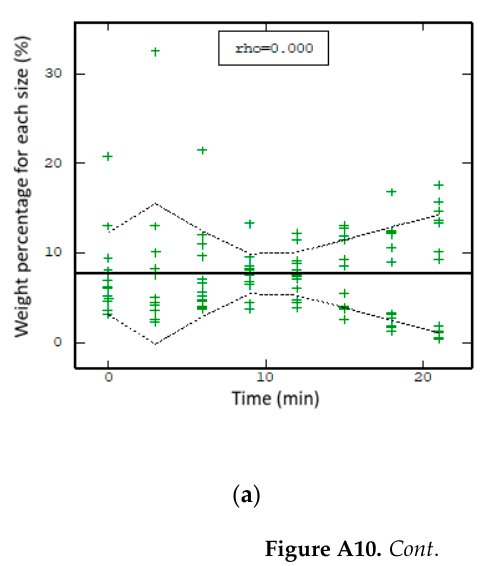
Figure A10. Cont